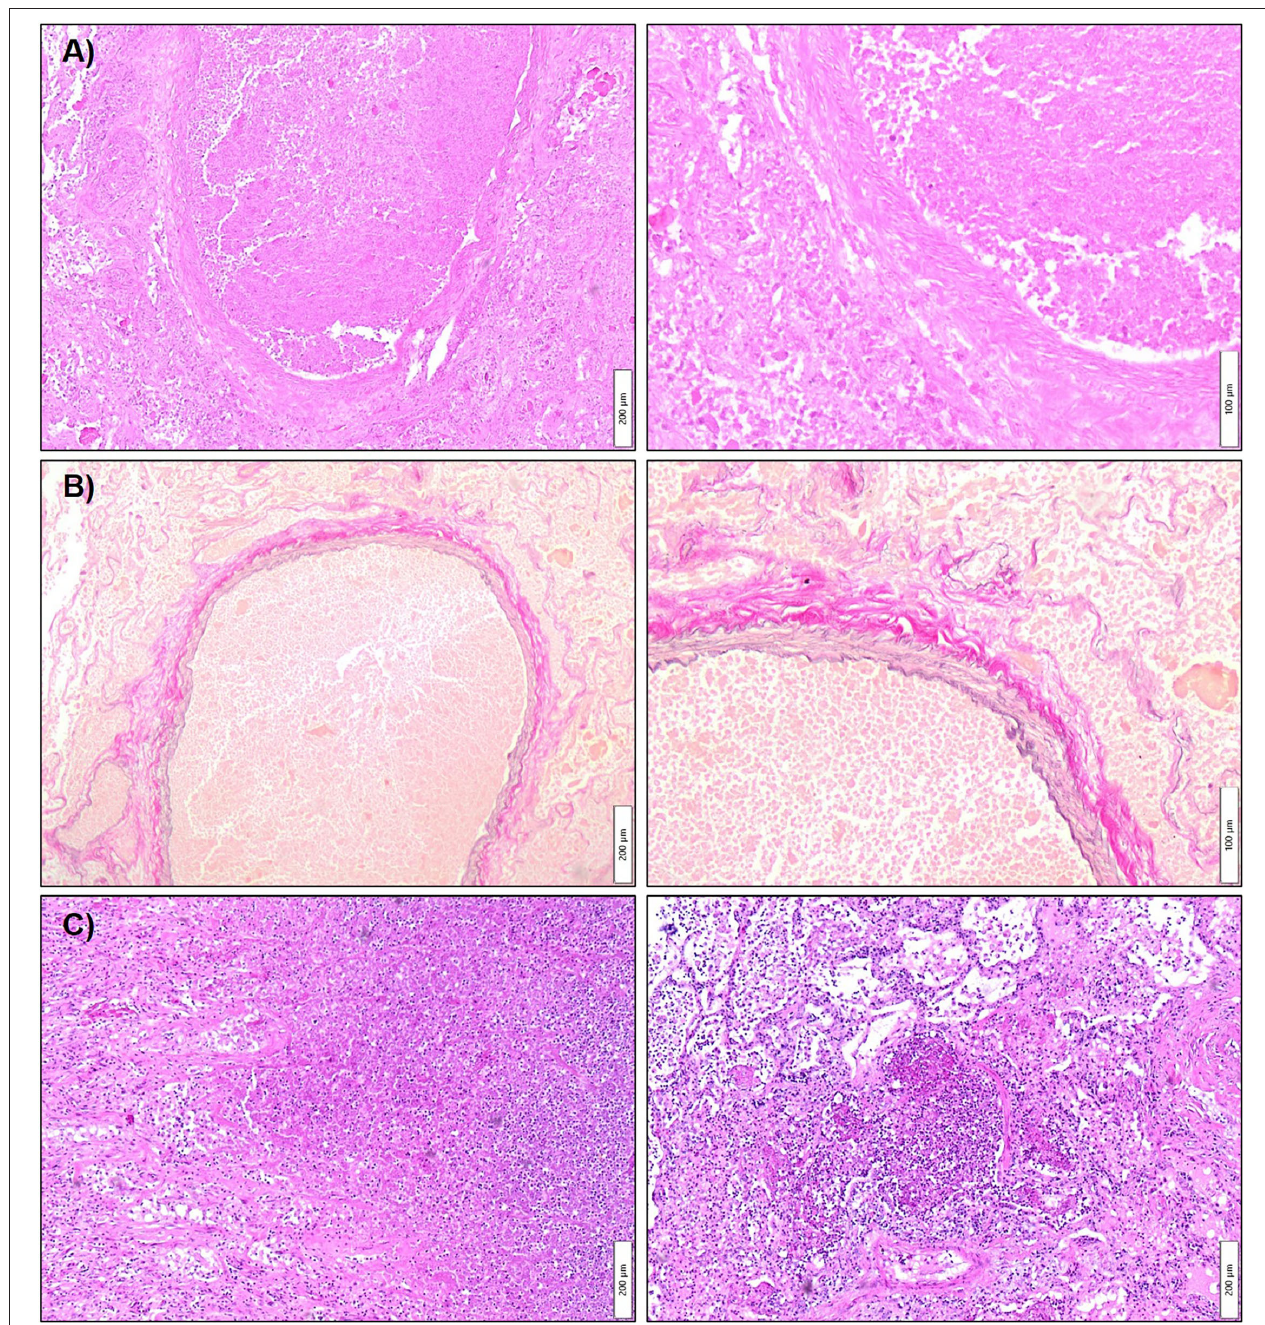
FIGURE 4 | Histopathology of the infectious aneurysm of the inferior lobe pulmonary artery and concomitant necrotizing bronchopneumonia. Tissue sections were acquired from the resected right lower lobe comprising the infectious aneurysm. Histopathological work-up was performed with Hematoxylin-Eosin (A,C) and Elastica van Gieson (B) staining. In (A) depicted two magnifications show a dilated pulmonary artery branch occluded by a granulocyte rich fibrin thrombus with accompanying vascular wall necrosis. (B) Highlights the same area in a trichrome staining revealing the dual elastic fiber network. (C) Shows the partially necrotizing, fibrinous-purulent pneumonia adjacent to the vascular changes. Meanwhile, no signs of malignancy were noted in the investigated specimen.